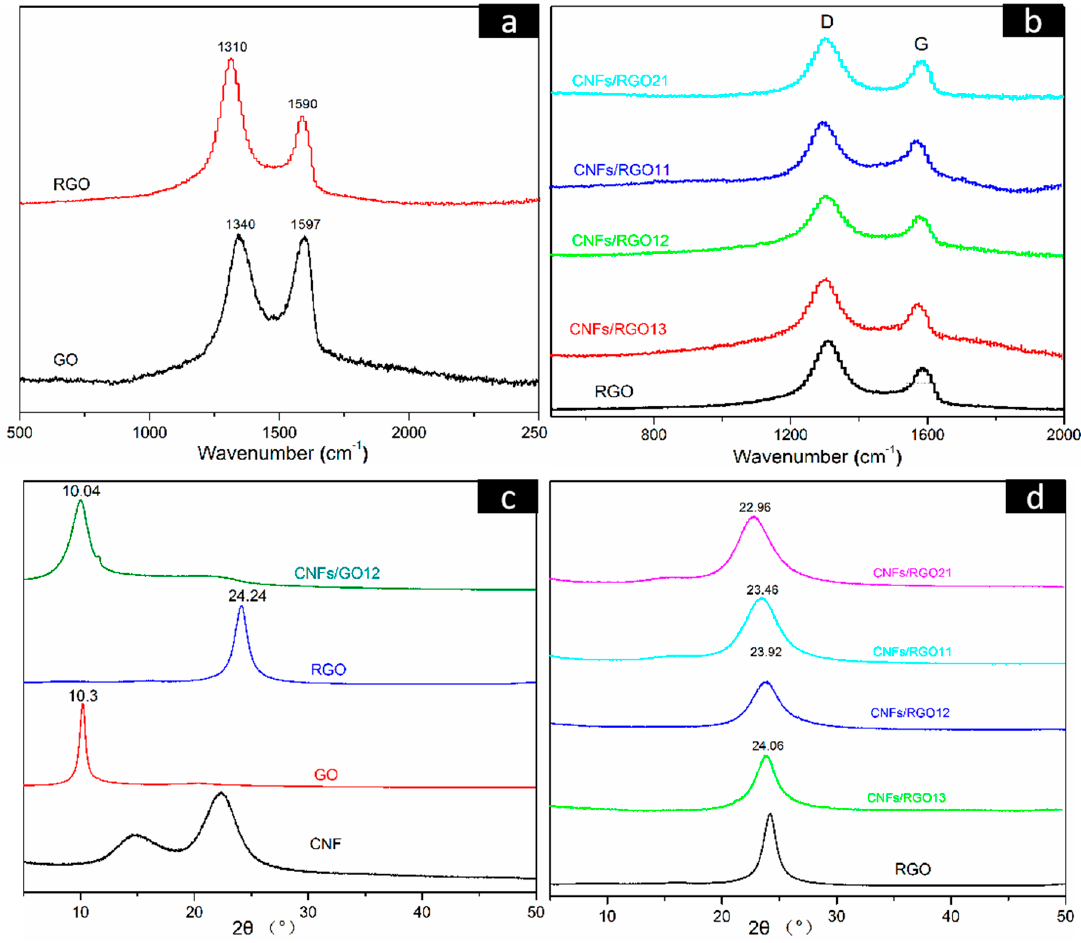
Figure 5. ( a , b ) Raman spectra of the GO, RGO, and CNF/RGO films. ( c , d ) X-ray Diffraction (XRD) patterns of the CNF, GO, RGO, CNFs/GO 12 , and CNF/RGO films.